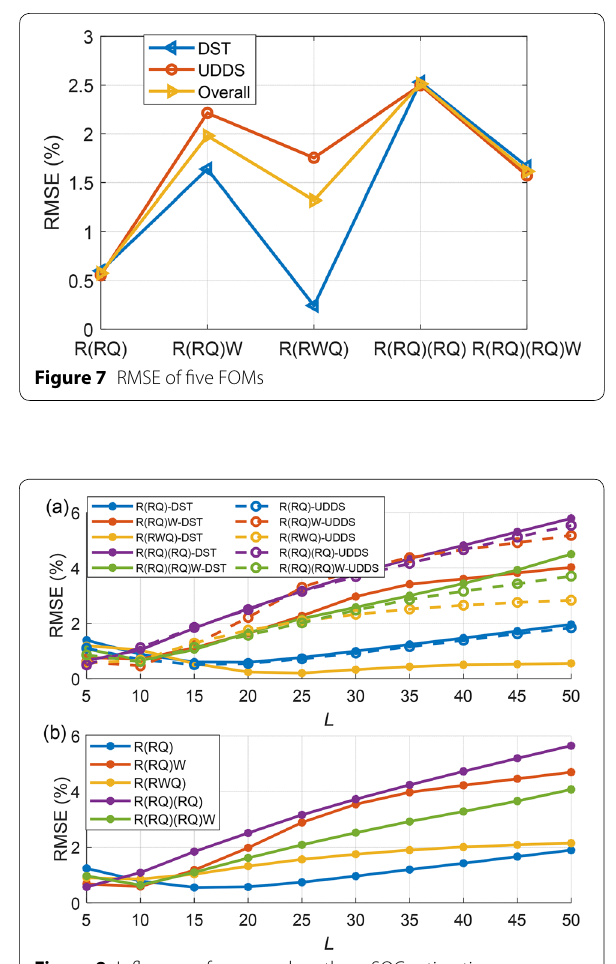
Figure 8 Influence of memory length on SOC estimation errors: a RMSEs for DST and UDDS profiles, b Overall RMSEs for two profiles